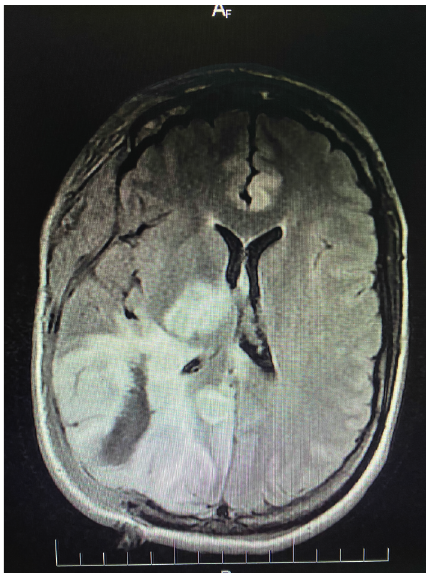
Figure 2: Magnetic resonance imaging (MRI) FLAIR axial head without contrast showing intraparenchymal hemorrhage status after